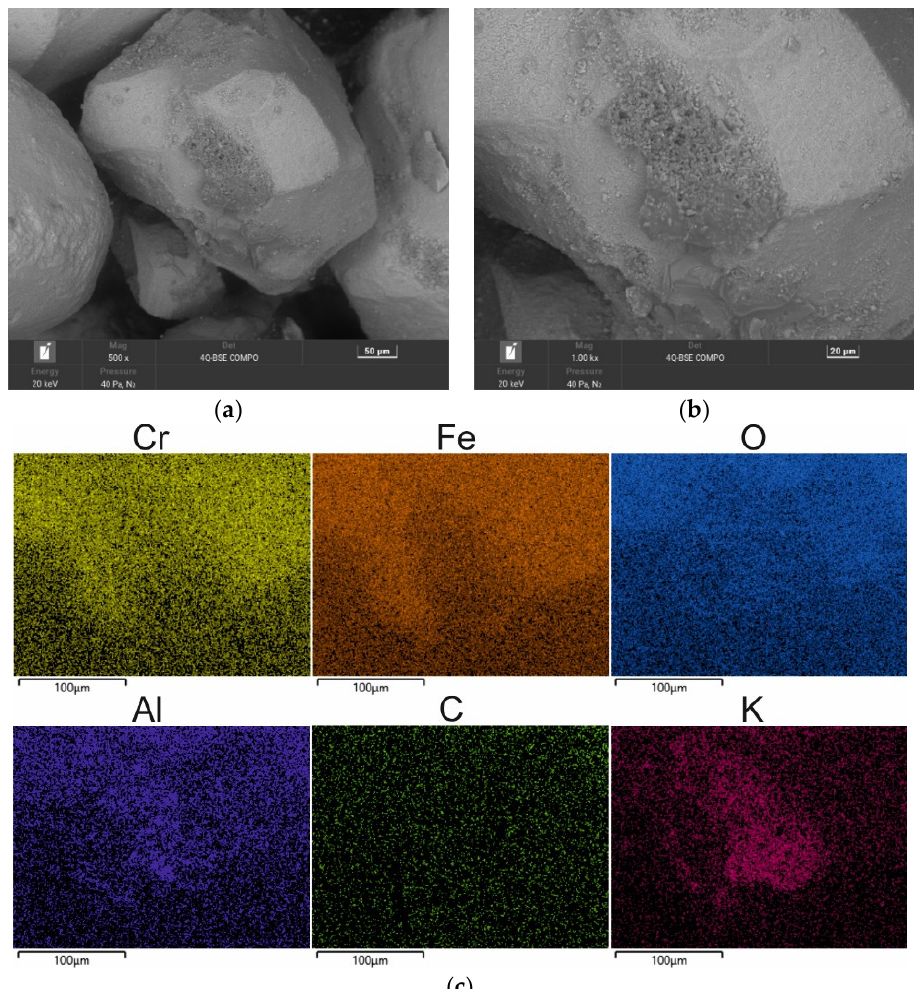
Figure 18. SEM image of 15 min MR15M-reclaimed sand after roasting for 2 h at 1000 °C: ( a ) mag. 200×; ( b ) mag. 1000×; ( c ) EDS map of element distribution in the analysed area of MR15M-reclaimed sand after roasting.